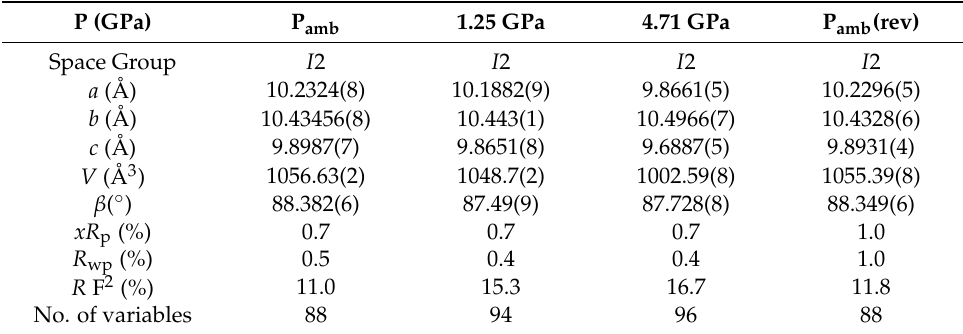
Figure 3. Selected integrated powder patterns, collected in silicone oil (s.o.) ( a ), and (16:3:1) methanol-ethanol-water (m.e.w.) ( b ), reported as a function of pressure. The patterns at the top of the figures were collected during decompression. ( c ) Observed and calculated profiles of the X-ray powder diffraction (XRPD) amicite pattern at 1.25 GPa. Table 1. Experimental and structural refinement parameters for the X-ray powder diffraction (XRPD) measurements performed on amicite in (16:3:1) methanol:ethanol:water (m.e.w.) at P amb , 1.25 GP, 4.71 GPa, and upon decompression (P amb (rev)).